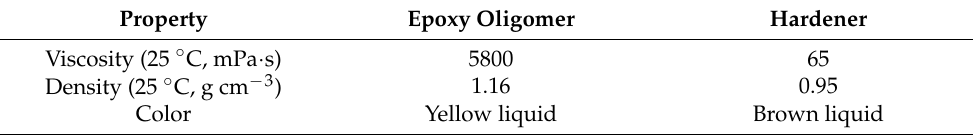
Table 7. Physical property of the epoxy resin for preparing epoxy asphalt